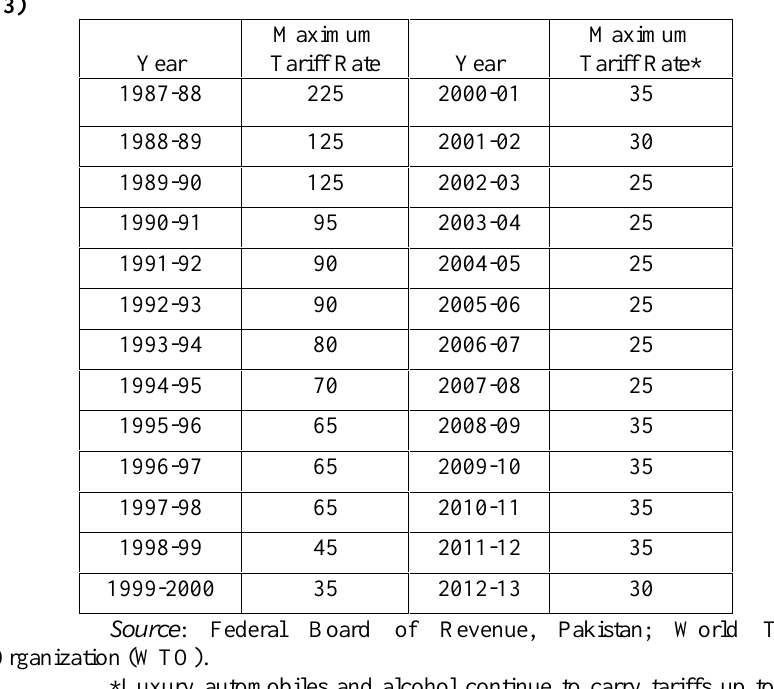
Table2: Tariff Reduction Schedule in Pakistan (1987-88 to